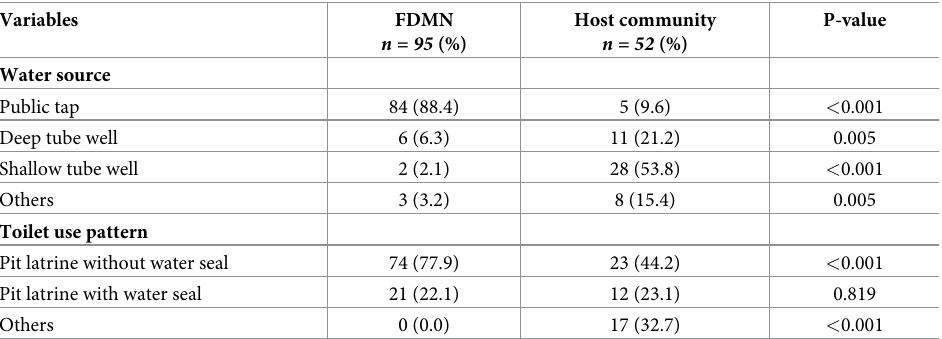
Table 2. Water source and toilet use by the culture-confirmed cholera patients in Leda and Teknaf DTCs in Cox’s Bazar settlements, September-December 2019.